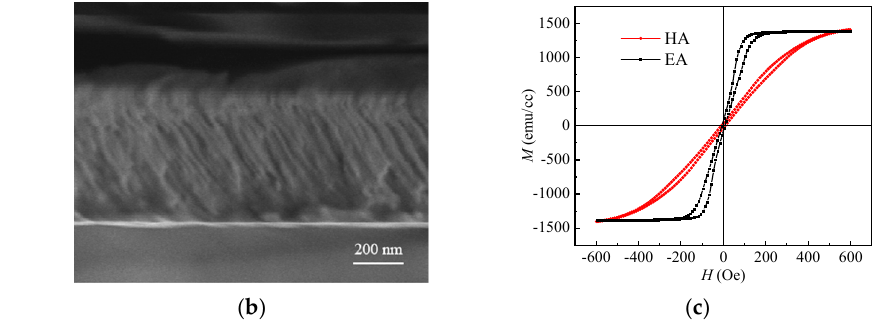
Figure 1. ( a ) Schematic diagram of oblique sputtering; ( b ) cross-section SEM image of a CoFeB thin film with a thickness of 450 nm on a PI substrate ( θ = 60 ◦ ); ( c ) normalized hysteresis loops of CoFeB fi lms.